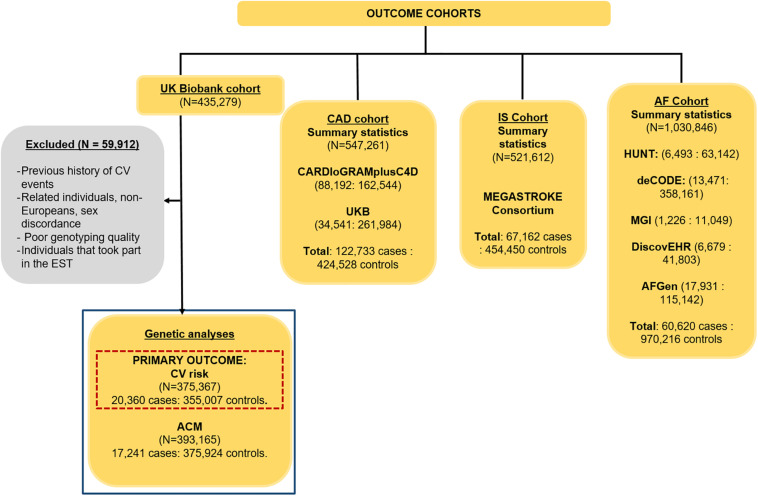
Cohorts used to assess the causality of HRI, HRR, and resting HR on CV events, ACM, CAD, IS, and AF, with their sample sizes and case–control ratios. A GWAS was performed in this project (highlighted in the blue box) for CV events (our primary outcome, highlighted in the dashed red box) and ACM, while the summary statistics were downloaded for CAD (Nelson et al., 2017), IS (Malik et al., 2018), and AF (Nielsen et al., 2018).